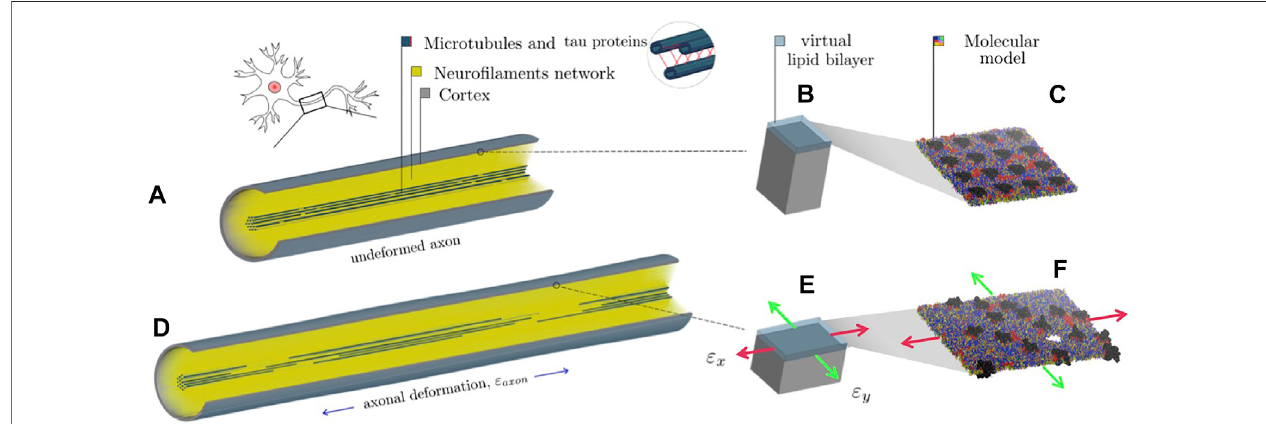
FIGURE 1 | Representation of the combined fi nite element-molecular based modeling approach (Montanino et al., 2020). (A) Finite element axonal model where a quarter of the model was removed to reveal the arrangement of the inner structures. (B) Single undeformed cortex element and a juxtaposed virtual lipid bilayer. (C) molecular bilayer model. (D) The axon fi nite element model is deformed of a quantity ( ε axon ). (E) Maximum localized deformations ( ε x ε y ) are extracted and applied to the molecular model. (F) Visualization of the induced pore upon deformation of the molecular model.